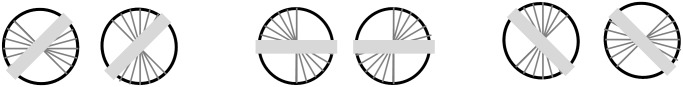
Visually displayed response options in the perceptual part of Experiment 3.Options are plotted individually for the 3 exploration tunnels (from left to right: 45°, 0°, 135°). The light grey bar depicts the exploration tunnel and the dark grey lines represent each for sample texture orientations. The left button always visualized the class of texture orientations rotated clockwise from the exploration tunnel, and thus texture orthogonals were rotated counterclockwise. The right button visualized the class, defined by counterclockwise rotation of orientation, and thus the texture orthogonal rotated clockwise from the exploration tunnel.